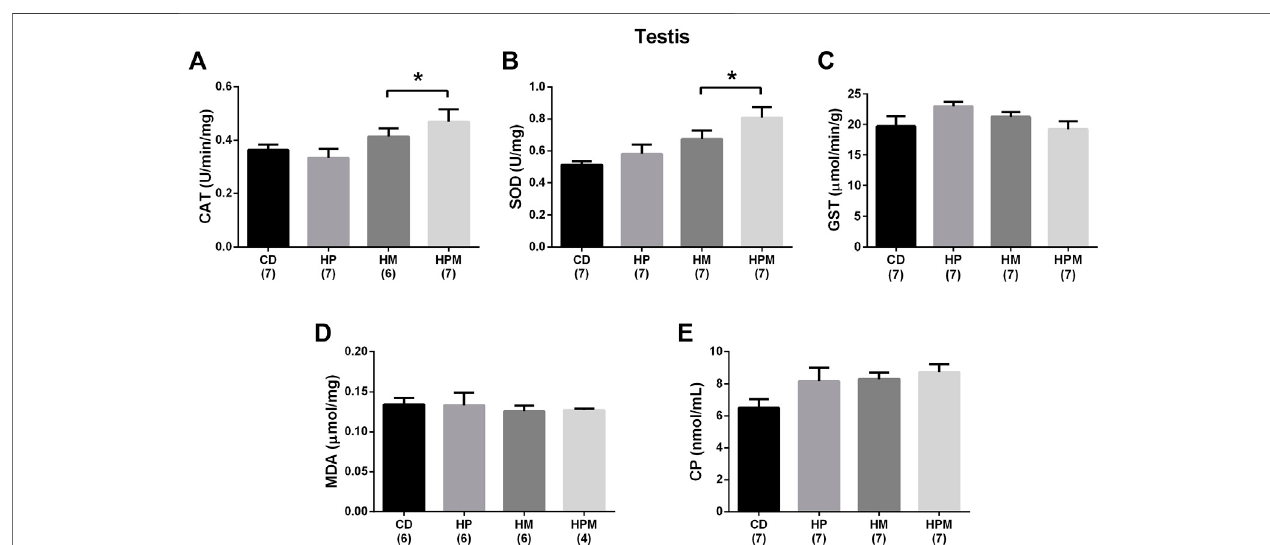
FIGURE5 | Testicular antioxidant enzyme activity and oxidative stressmarkersin male rat offspring from progenitors fedon high-fat high-sugar diet. Mean ±SEM; symbolsindicatesigni fi cantdifferencecausedbyparentaldiet( p < 0.05):*statisticallysigni fi cantbytheeffectofmaternaldiet.H:high-fatandhigh-sugardiet;CD(control paternal and maternal diet), HP (H paternal diet and control maternal diet), HM (H maternal diet and control paternal diet) and HPM (H paternal and maternal diet). (A) catalase(CAT)(U/min/mg)( n =6-7); (B) :superoxidedismutase(SOD)(U/mg)( n =7); (C) :glutathioneS-transferase(GST)( μ mol/min/g)( n =7); (D) :malondialdehyde